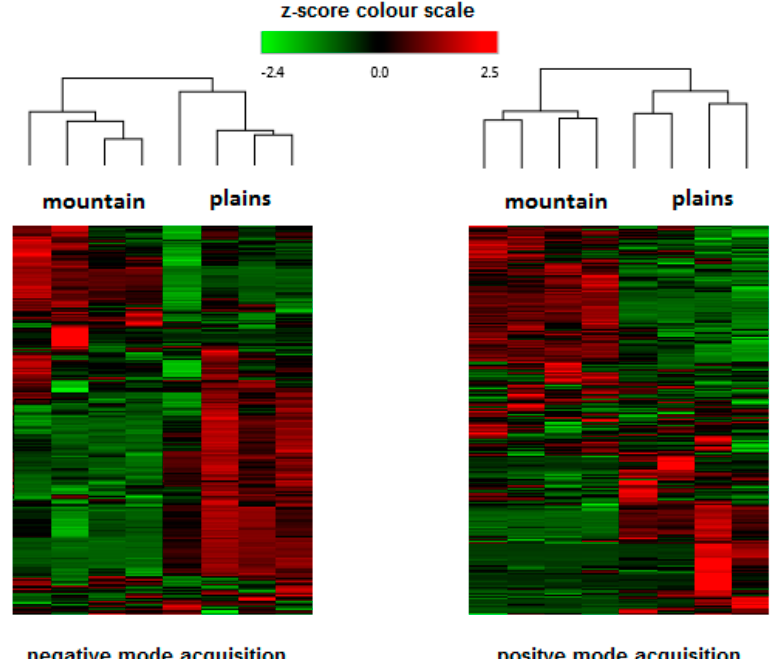
Figure 2. Hierarchical cluster analysis: heat-map reflecting the differences between compounds revealed in Kompolti inflorescences in respect to different geographical/climatic conditions.